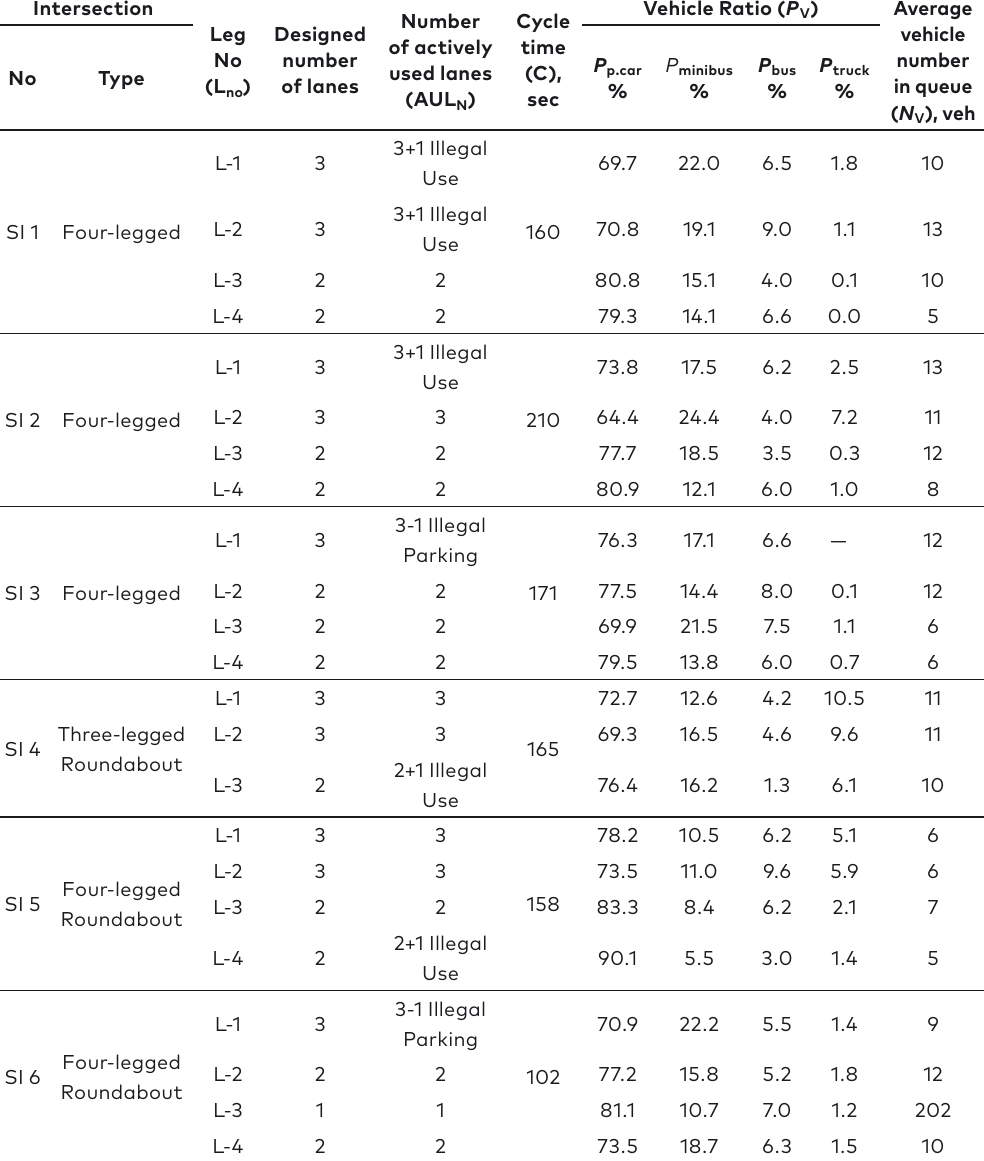
Table 1. Information about the collected data and examined signalized